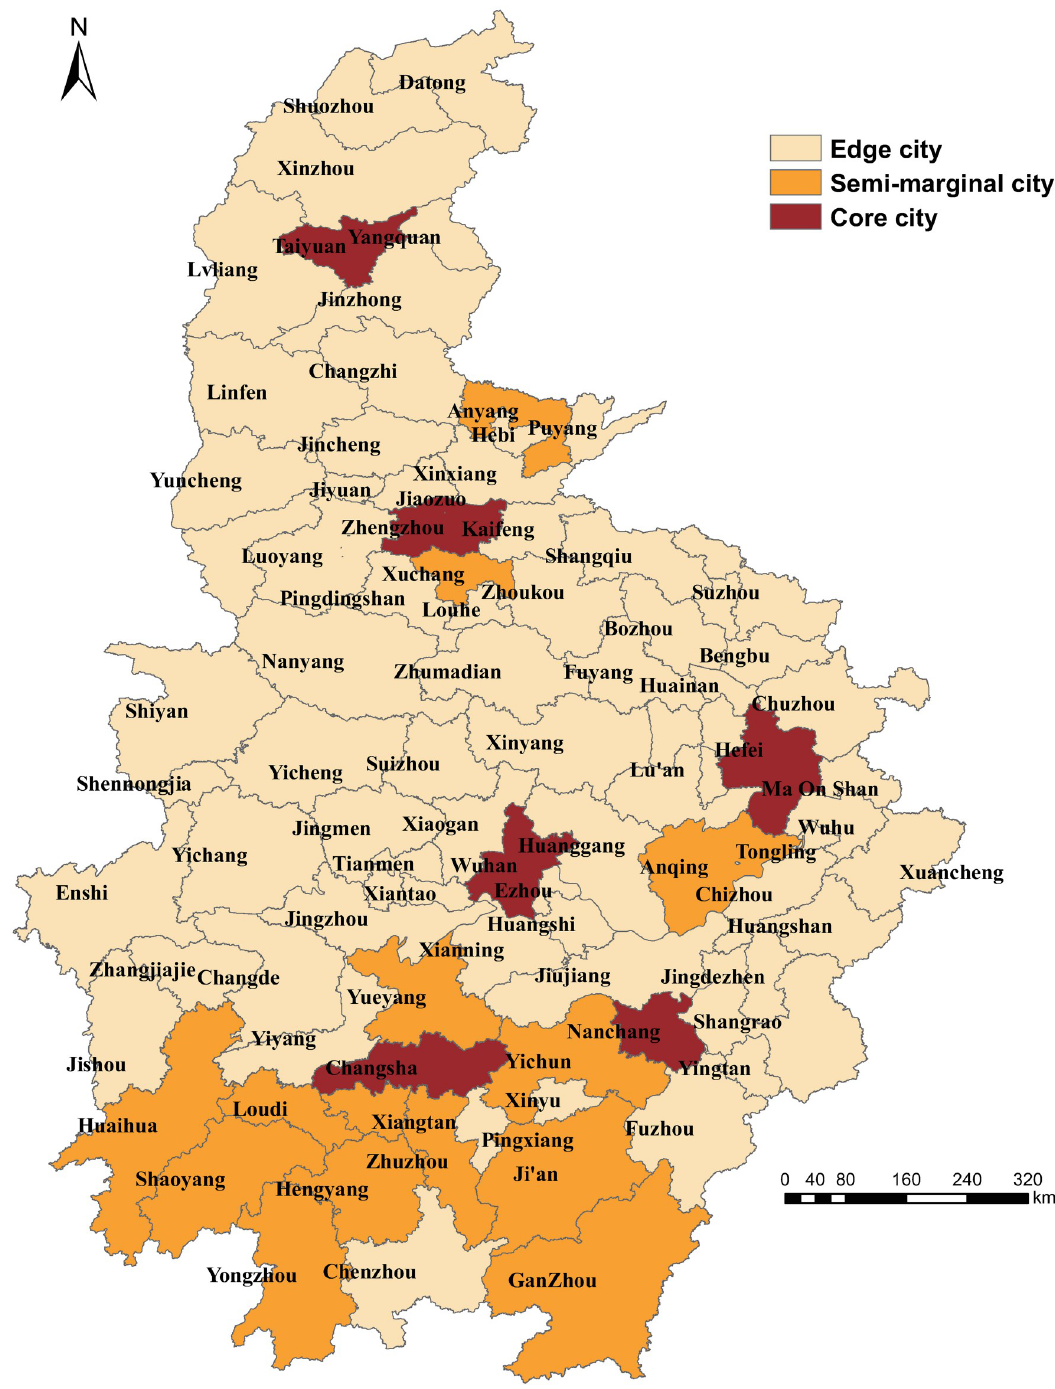
Fig 6. Core-periphery analysis of the freight demand network.